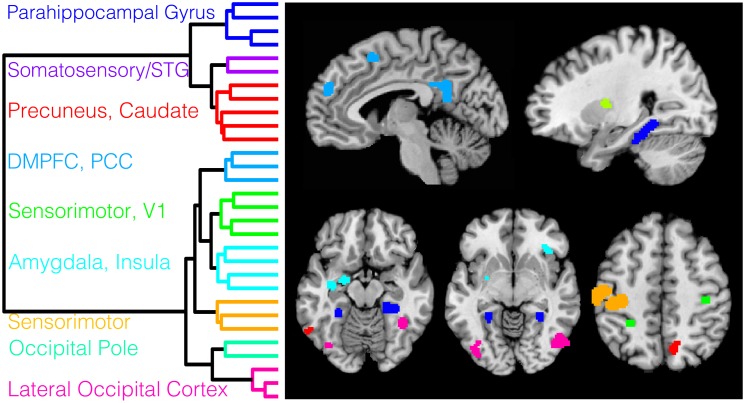
PINES clustering based on shared patterns of connectivity.This figure depicts the results of the hierarchical clustering analysis of the functional connectivity of the largest regions from the p < 0.001 thresholded PINES pattern. Clusters were defined by performing hierarchical agglomerative clustering with ward linkage on the trial-by-trial local pattern responses for each region using Euclidean distance. Data were ranked and normalized within each participant and then aggregated by concatenating all 61 subjects’ trial x region data matrices. Panel A depicts the dendrogram separated by each functional network. Panel B depicts the spatial distribution of the networks. Colors correspond to the dendrogram labels.